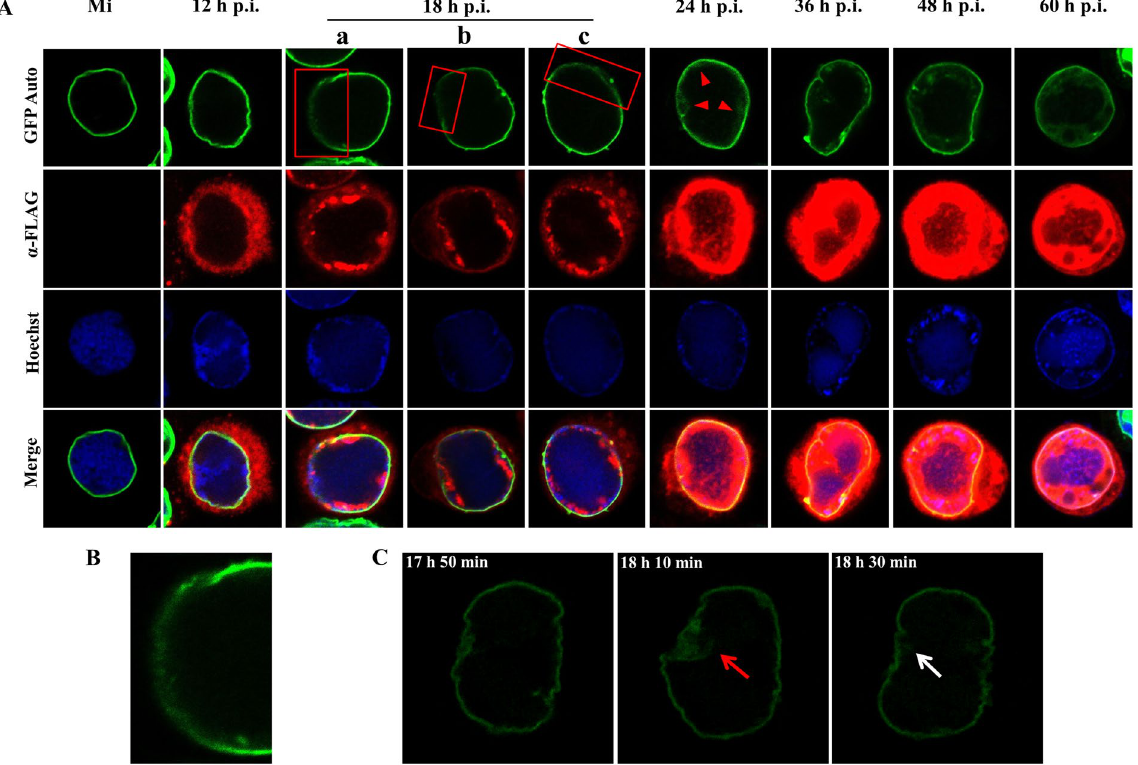
Figure 3. Subcellular localization of GFP-lamin B in Sf9-L cells. ( A ) Immunofluorescence microscopy analysis. Sf9-L cells were mock-infected or infected with vAc76:FLAG at an MOI of 5. At the designated time points p.i., the cells were fixed, permeabilized, stained with a mouse monoclonal anti-FLAG antibody, and visualized with donkey anti-mouse IgG conjugated to Alexa Fluor 555 (red) as the secondary antibody to detect Ac76. GFP- lamin B was detected based on GFP autofluorescence (GFP-Auto, green). Hoechst 33342 was used to identify nuclei and DNA-rich regions (blue). The red rectangles indicate the diffuse localization of a portion of the nuclear rim GFP-lamin B, and the red triangles show the distribution of GFP-lamin B at the periphery of the nucleus. ( B ) Higher magnification image of the boxed region in ( Aa ). ( C ) Live confocal microscopy images of a virus-infected Sf9-L cell between 17 h 50 min and 18 h 30 min p.i. A portion of the nuclear rim GFP-lamin B showed diffuse localization (red arrow) and then recovered (white